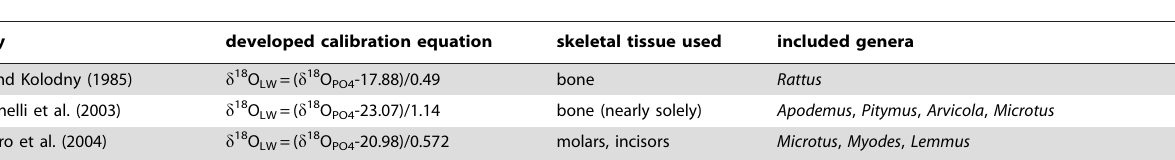
Table 5. Existing calibration equations between d 18 O LW and d 18 O PO4 for rodents.